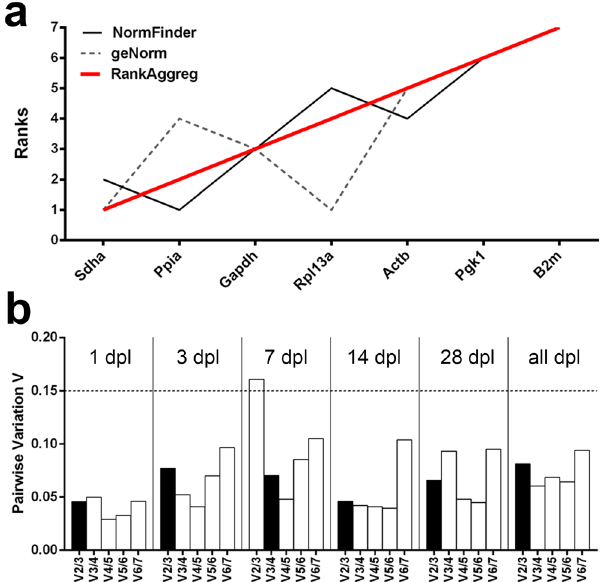
Figure 6. Evaluation of consensus ranking and determination of the optimal number of reference genes by pairwise variation for the outer molecular layer after entorhinal denervation. ( a ) Expression stability of candidate reference genes for all time-points after entorhinal denervation analyzed with NormFinder and geNorm. RankAggreg was used for consensus ranking analysis. ( b ) Determination of the optimal number of reference genes recommended for accurate normalization based on the analysis of pairwise variation (V) implemented in geNorm. Every bar represents the change in normalization accuracy by stepwise inclusion of an additional reference gene according to the ranking at specific time points (1, 3, 7, 14, 28 days post lesion, dpl) or for the entire lesion period (all dpl). A cut-off of 0.15 (dashed line) was set below the inclusion of additional reference genes was not required for normalization. Pairwise variation analysis revealed a minimum number of three reference genes for accurate normalization with the exception at 7 days post lesion, where a minimal number of four reference genes was